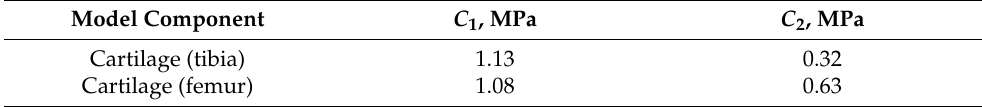
Table 1. Elastic constants of tibia cartilage and femur cartilage. Model